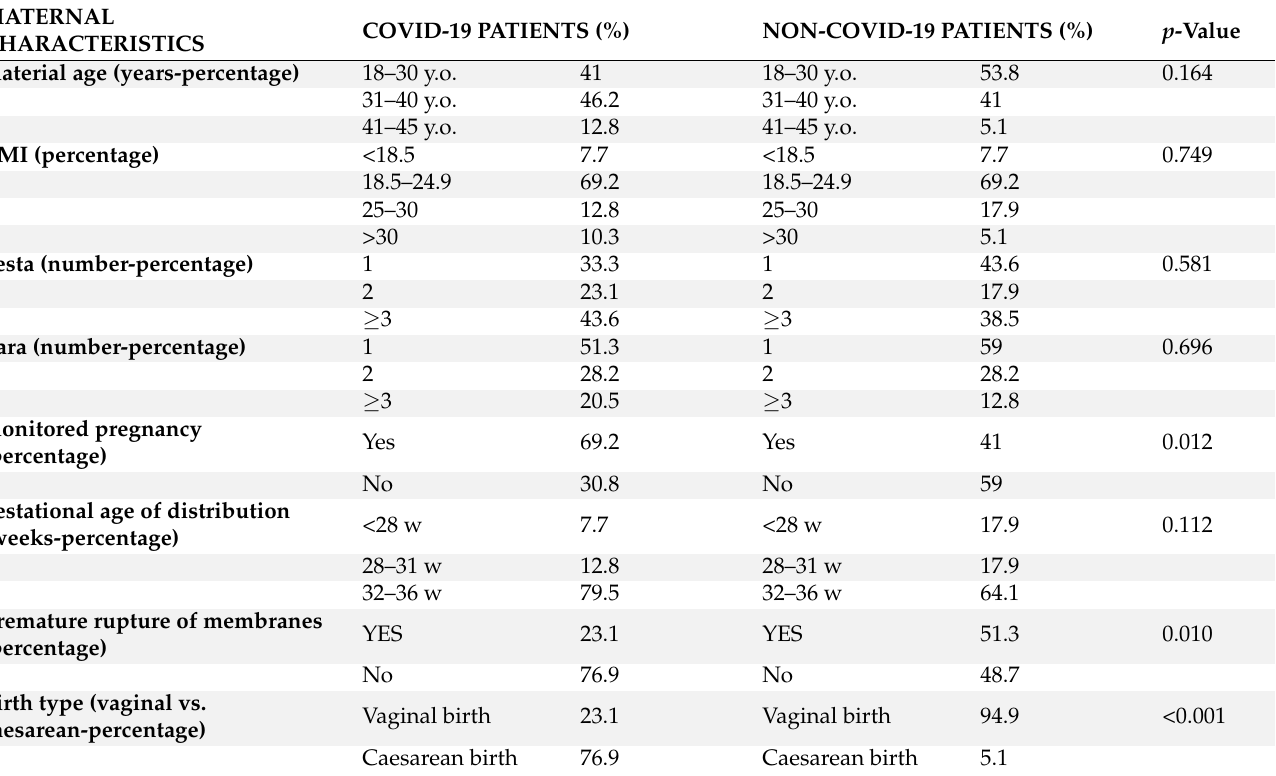
Table 1. General and obstetrical characteristics in COVID-19 positive vs. non-COVID-19 patients with premature birth.